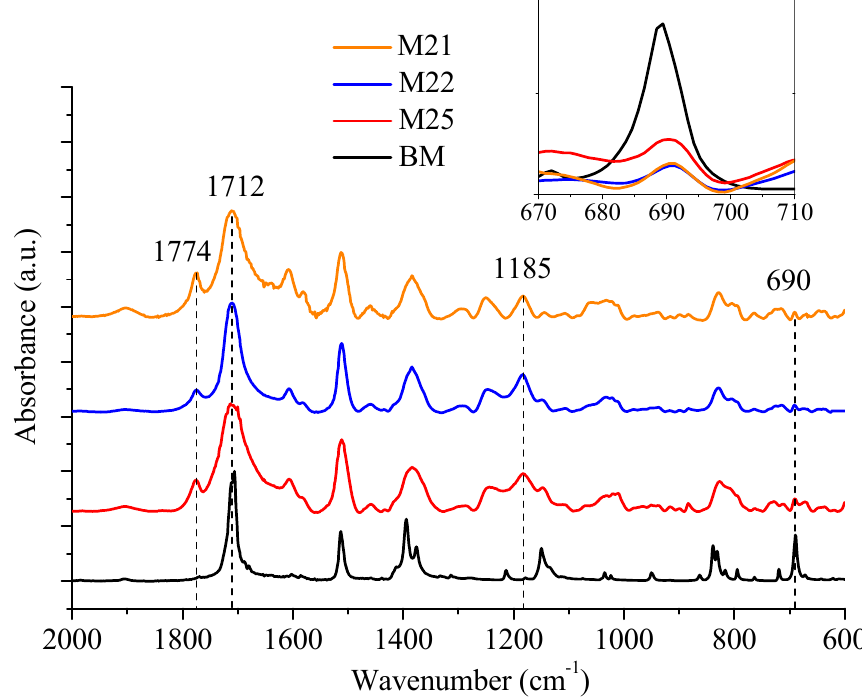
Figure 1. FTIR spectra of crosslinked samples M21, M22, M25 with different furan average functionality, compared to aromatic bismaleimide (BM). In the inset, the peak associated to C–H in maleimide rings (690 cm − 1 ) is highlighted.